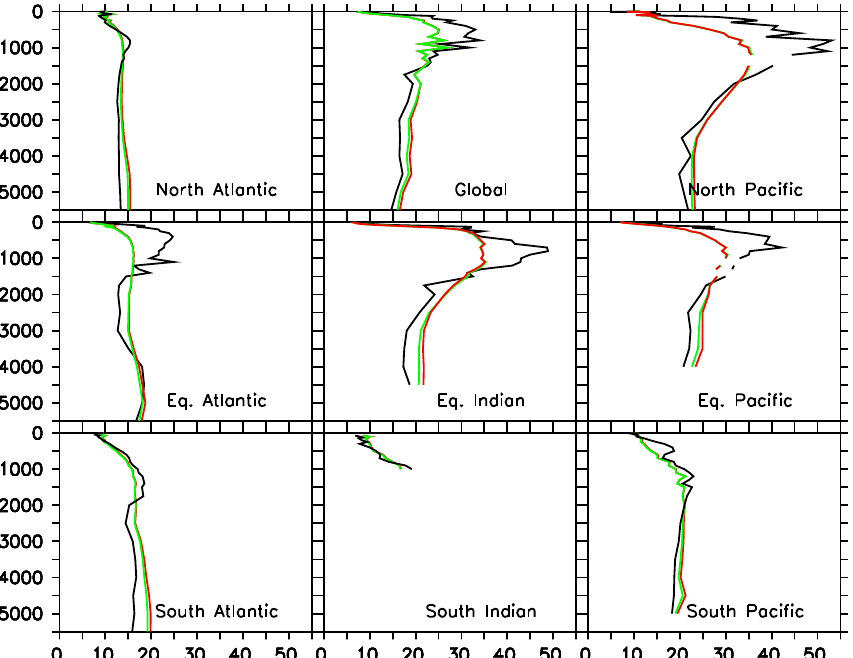
Figure 7. Depth profiles of N 2 O concentration (nmolL − 1 ) for different basins. Black lines: observations; green lines: optimised diagnostic model; red lines: optimised prognostic